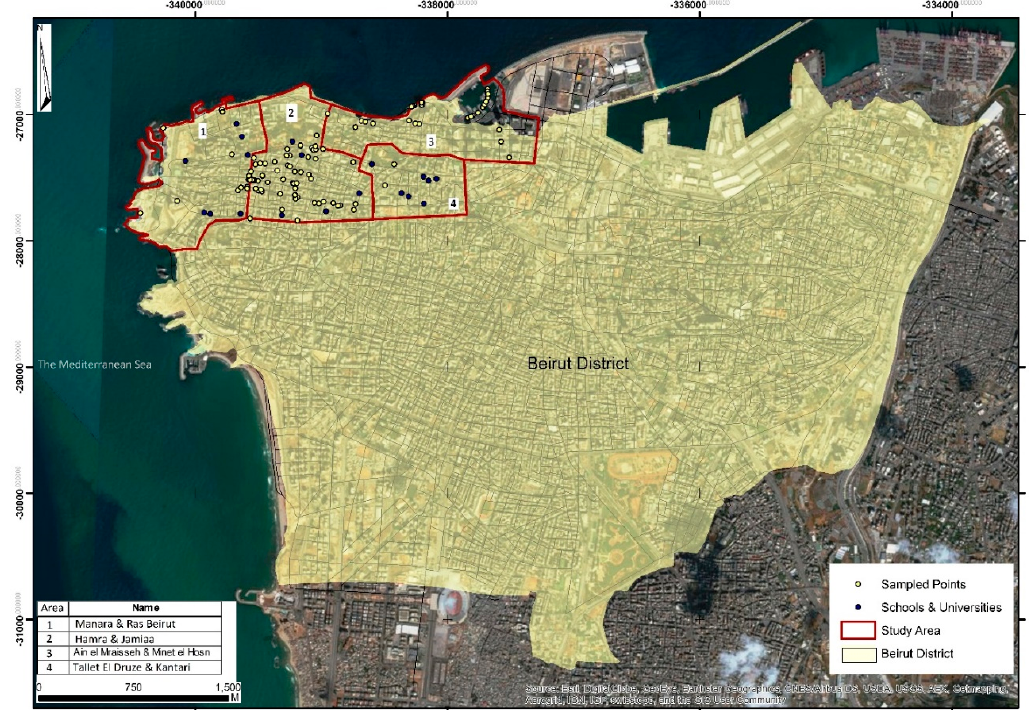
Figure 1. Beirut district with the surveyed study area outlined in red.